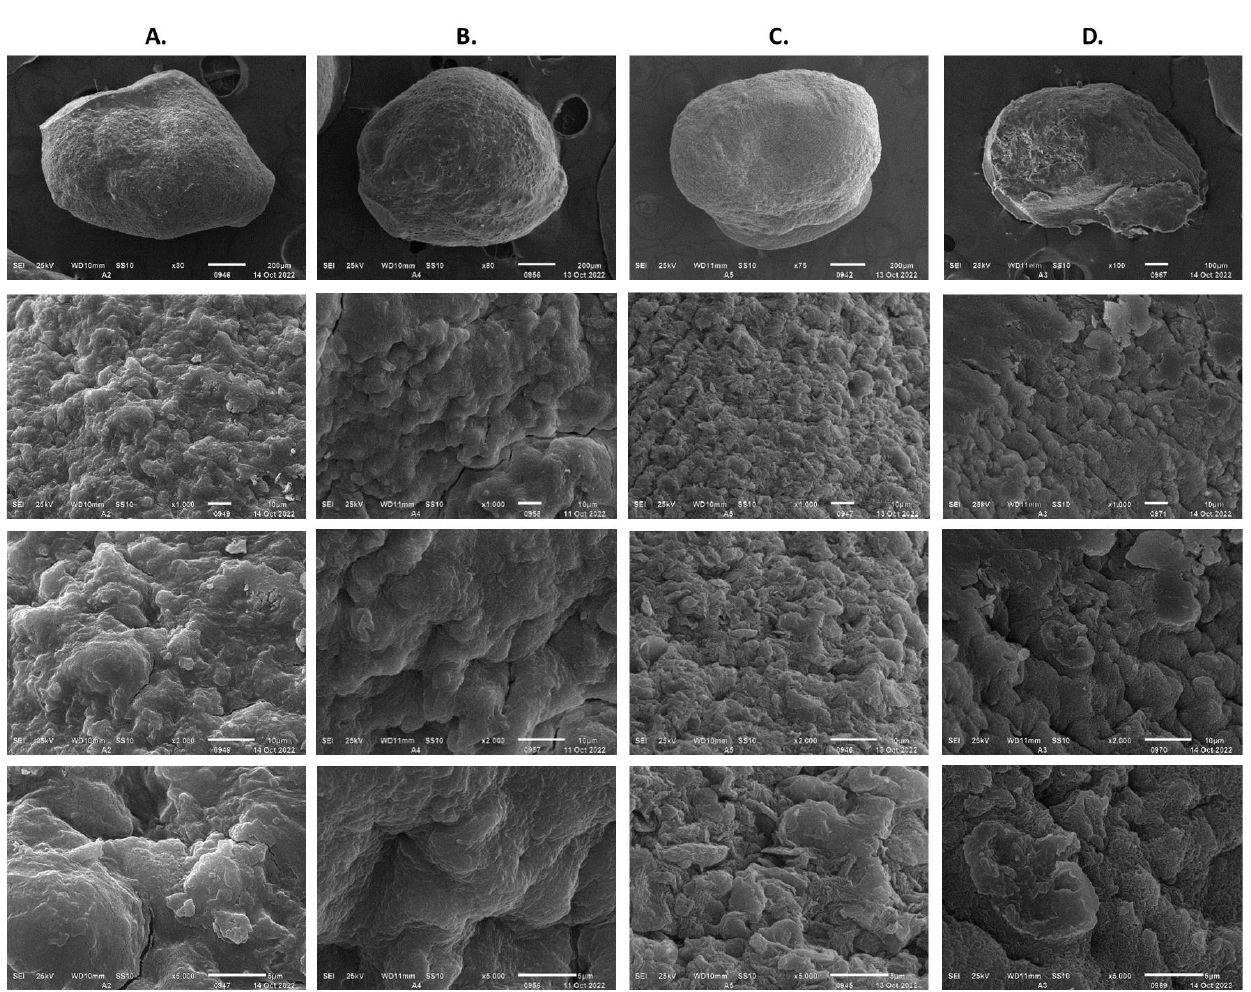
Figure 14. Calcium alginate capsules including protectors: ( A ) Trehalose incorporated in the YGM medium for the Streptomyces propagation. ( B ) Trehalose incorporated in the sodium alginate solution. ( C ) Kaolin incorporated in the sodium alginate solution. ( D ) Gum arabic incorporated into the alginate capsule surface.